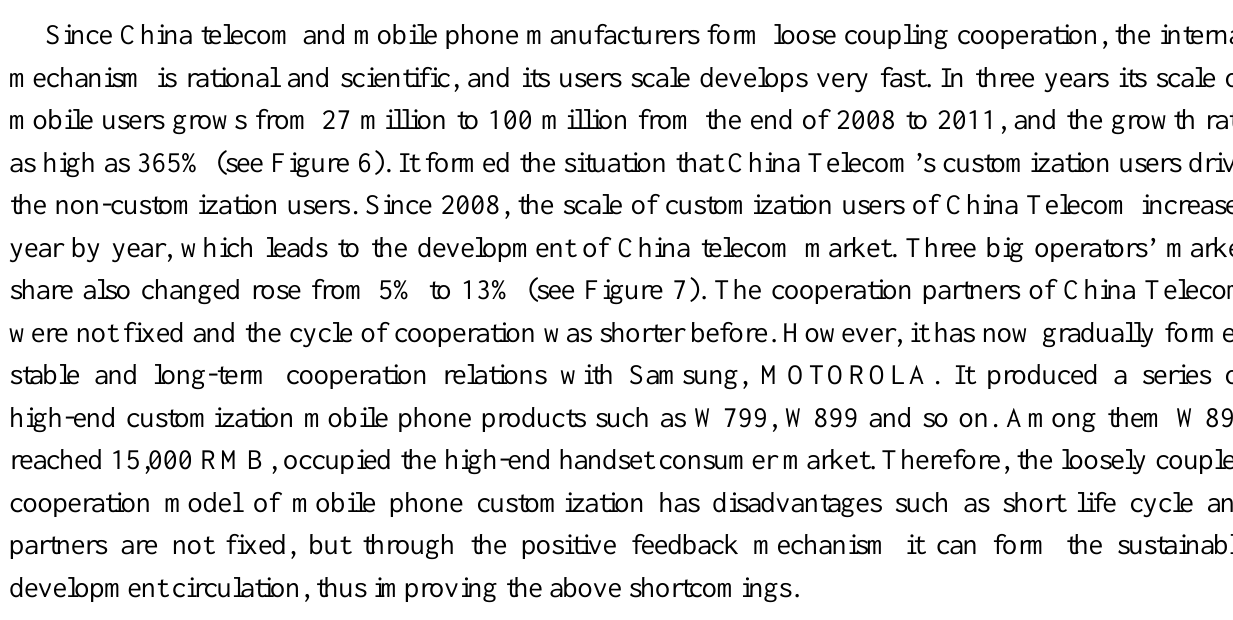
Figure 6. 3G customization mobile users’ scale of China Telecom from 2008 to 2011.